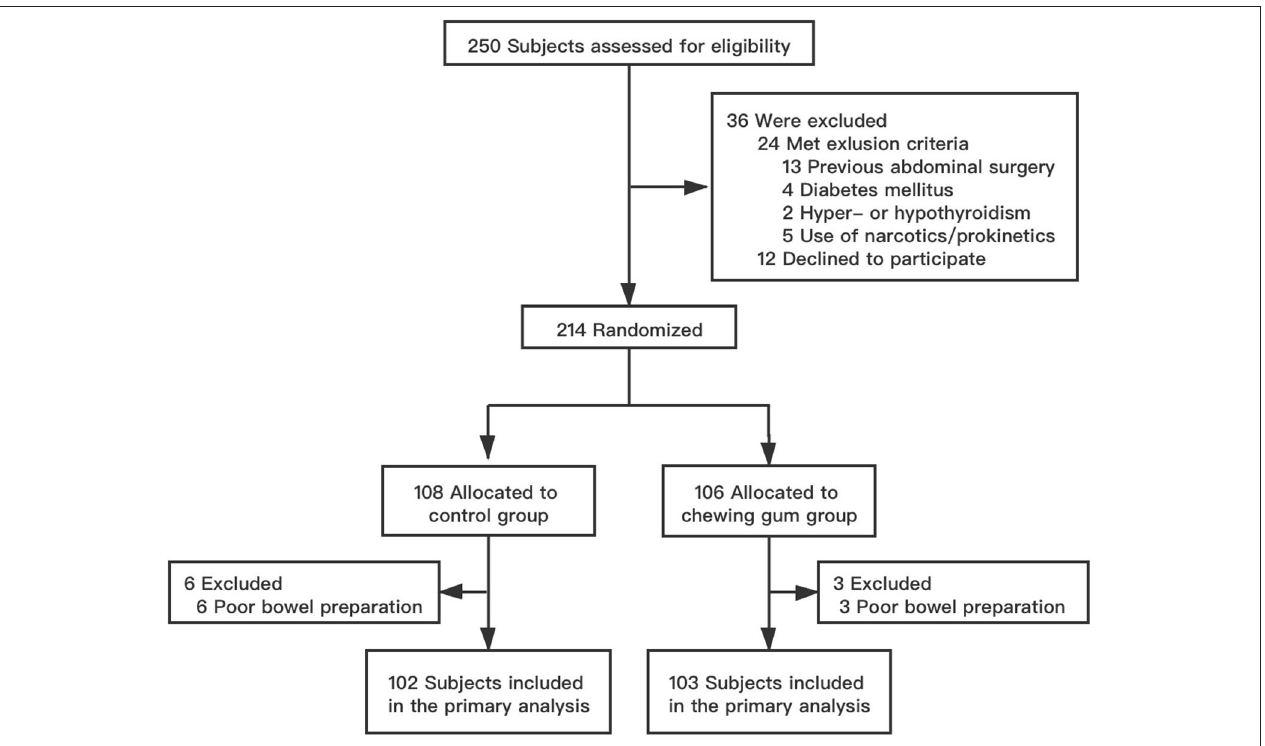
FIGURE 1 | Flowchart of the